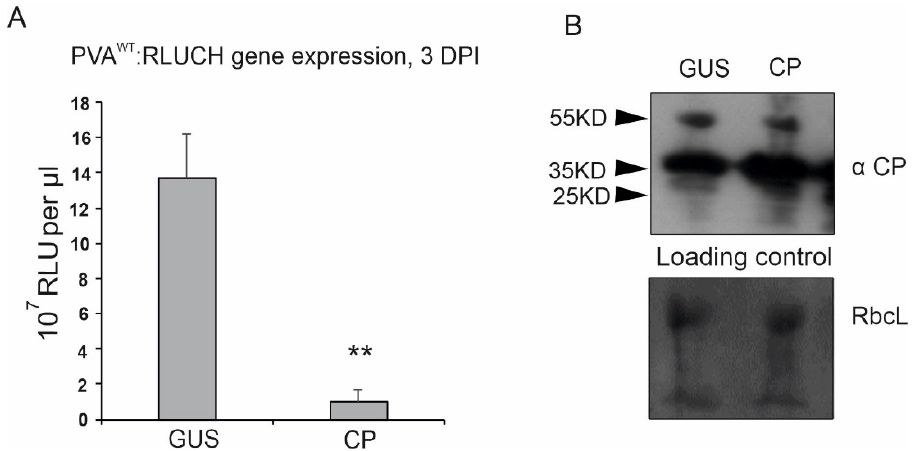
Figure 4. PVA CP inhibits viral RNA translation from the entire length of PVA RNA. ( A ) Viral translation from PVA WT carrying the rluc cistron in front of the HCPro cistron (PVA WT :RLUCH) was determined as RLUC activity at 3 dpi. ( B ) The western blot analyses with anti-CP antibodies show CP production from the PVA genome in the GUS control lane and its transient overexpression in the CP lane. Notably, PVA RNA translation is blocked in the latter case. p < 0.01 = **. The next CP-inhibition experiments were carried out using PVA WT and two PVA mutants, one incapable of cell-to-cell movement (PVA CPmut ) and the other defective in ∆ GDD ∆ GDD replicase activity (PVA ) [27]. PVA CPmut and PVA RNAs carry the Rluc gene